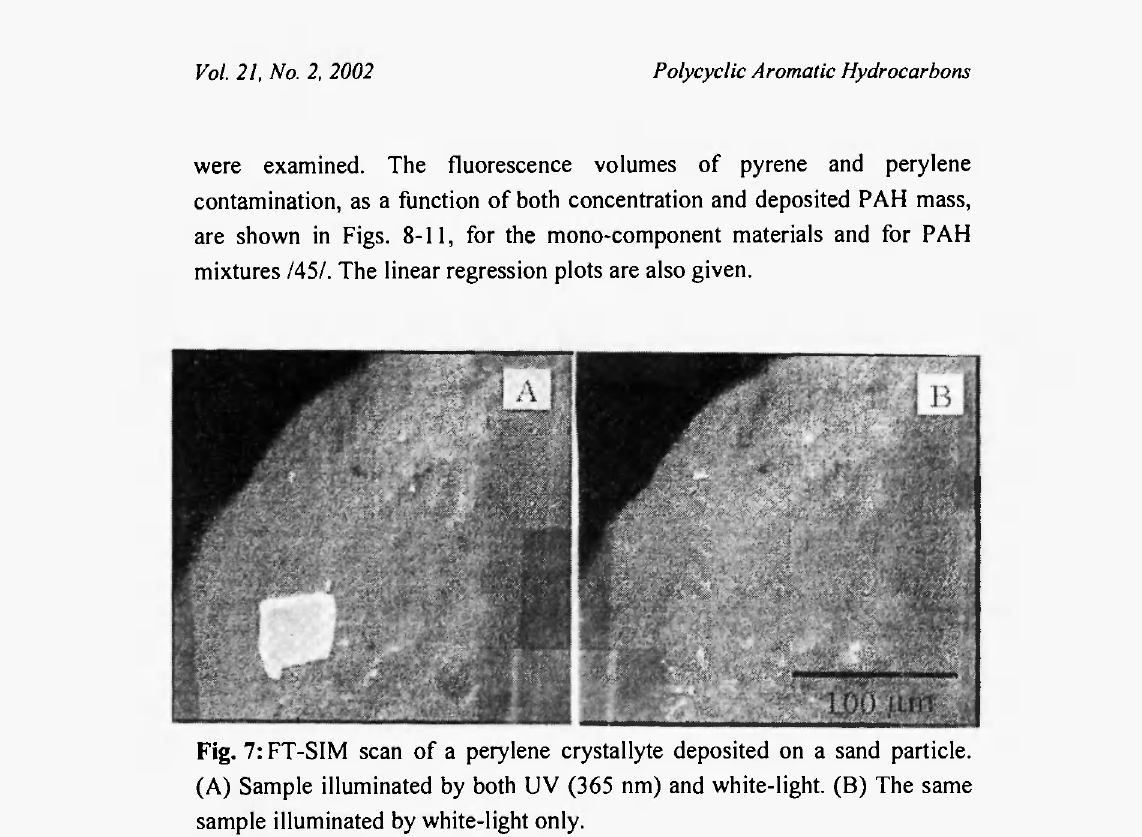
C o n c e n t r a t i on / p pm